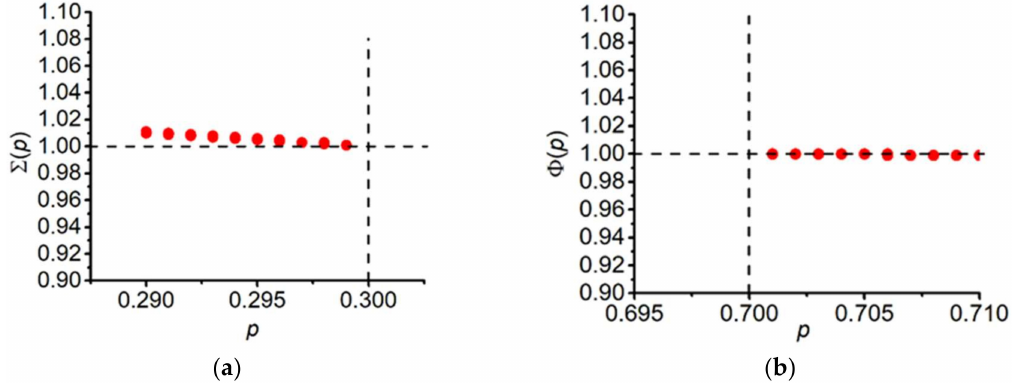
Figure A1. ( a ) Concentration dependence of the function Σ ( p ) for p c = 0.3 ( G 1 = ∞ ); ( b ) Concentration dependence of the function Φ ( p ) for p c = 0.7 ( G 2 =